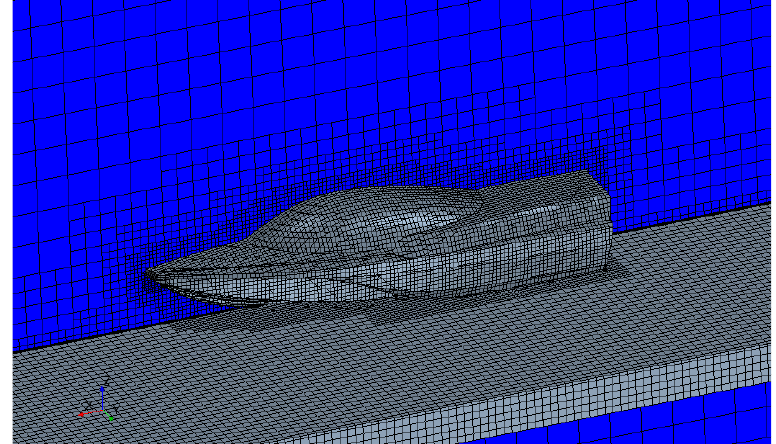
Figure 6. Grid around hull.